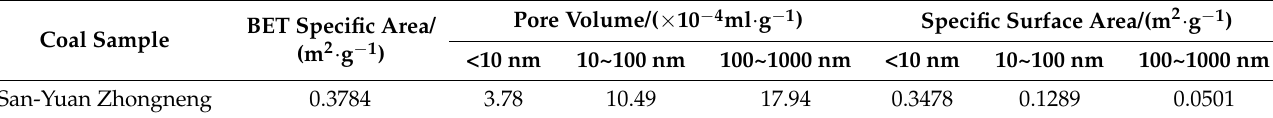
Table 2. Pore structure parameters of coal samples.